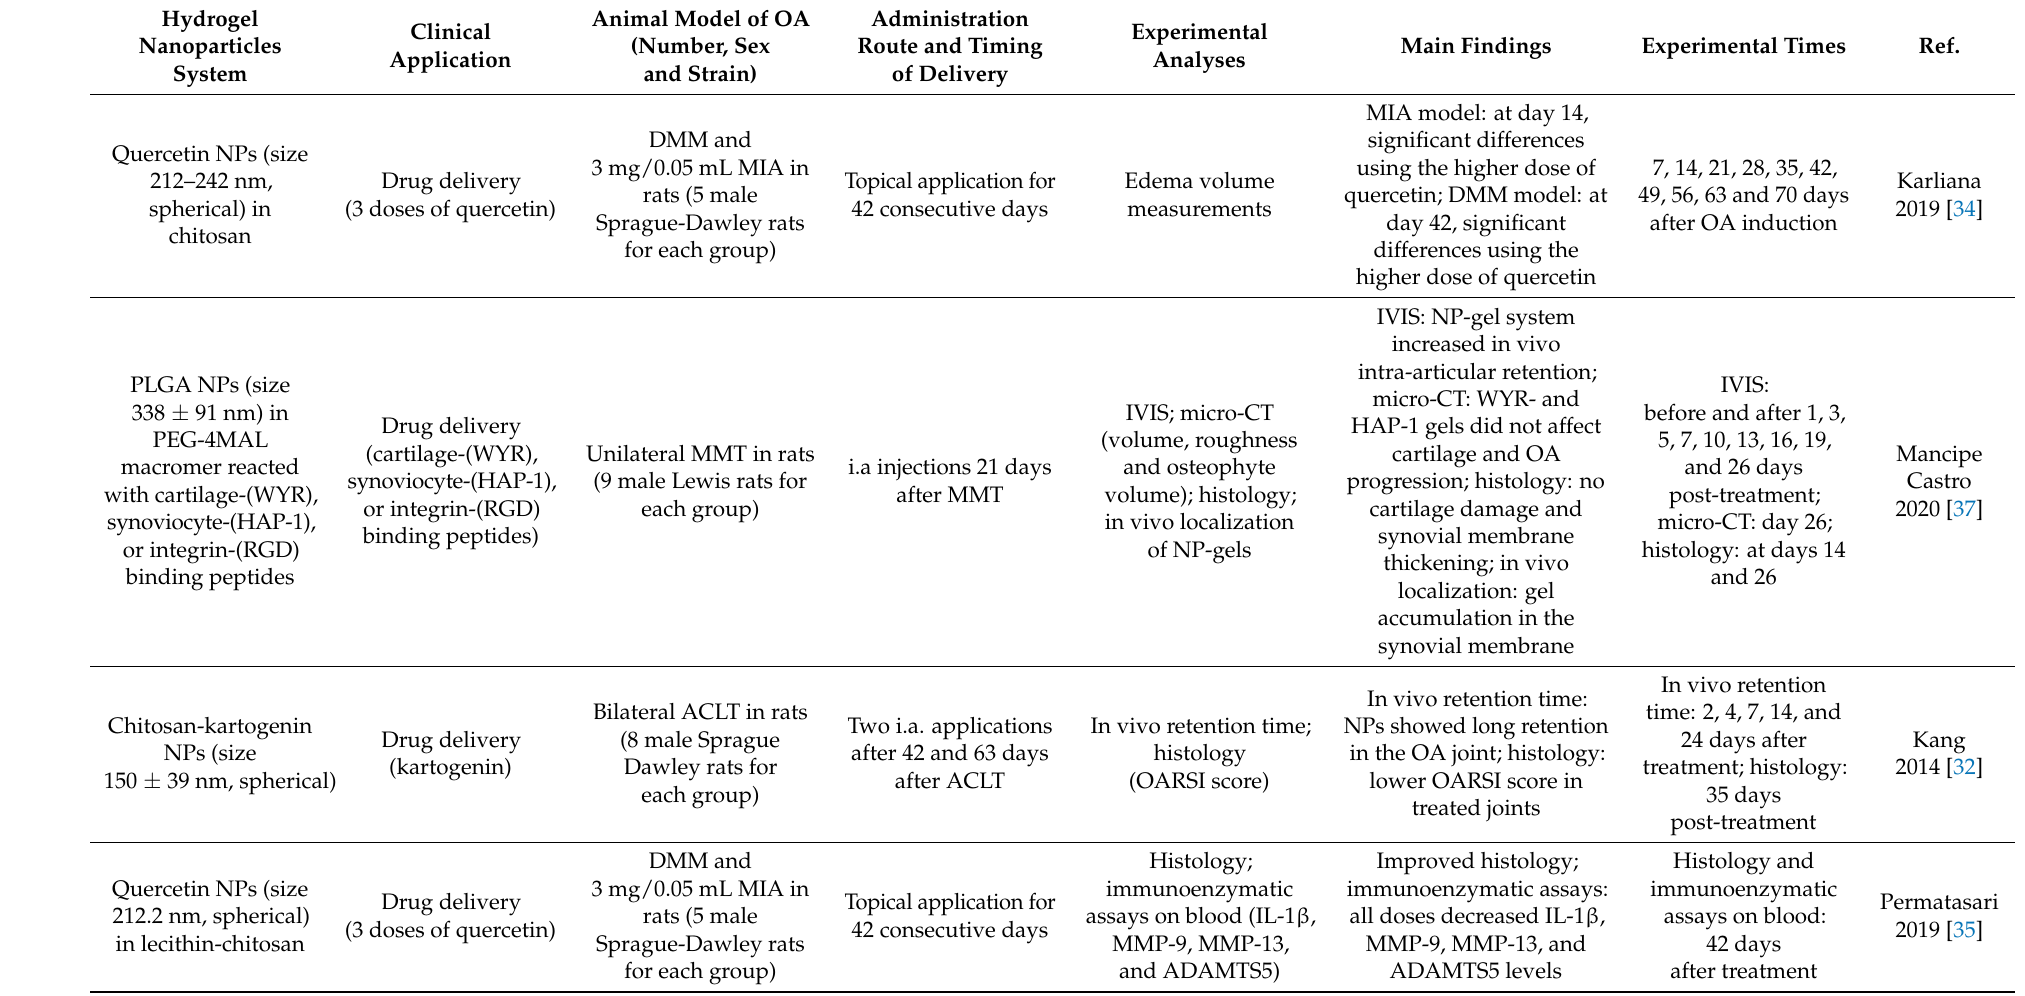
Table 2. Summary of the in vivo preclinical